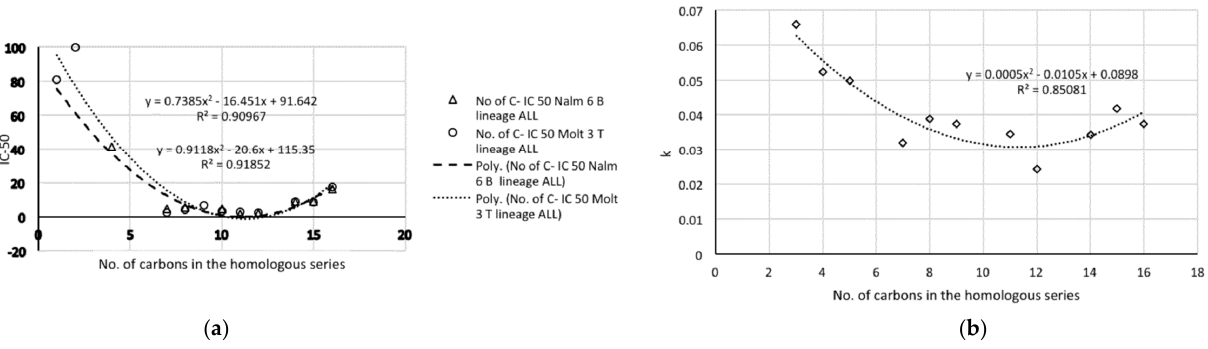
Figure 7. Experimental data: ( a ) IC 50 antileukemic activity and ( b ) stability k vs. the number of carbons. Figure 8 displays surface tension data vs. the number of carbons for the homologous series. The surface tension decays monotonically with the number of carbons.